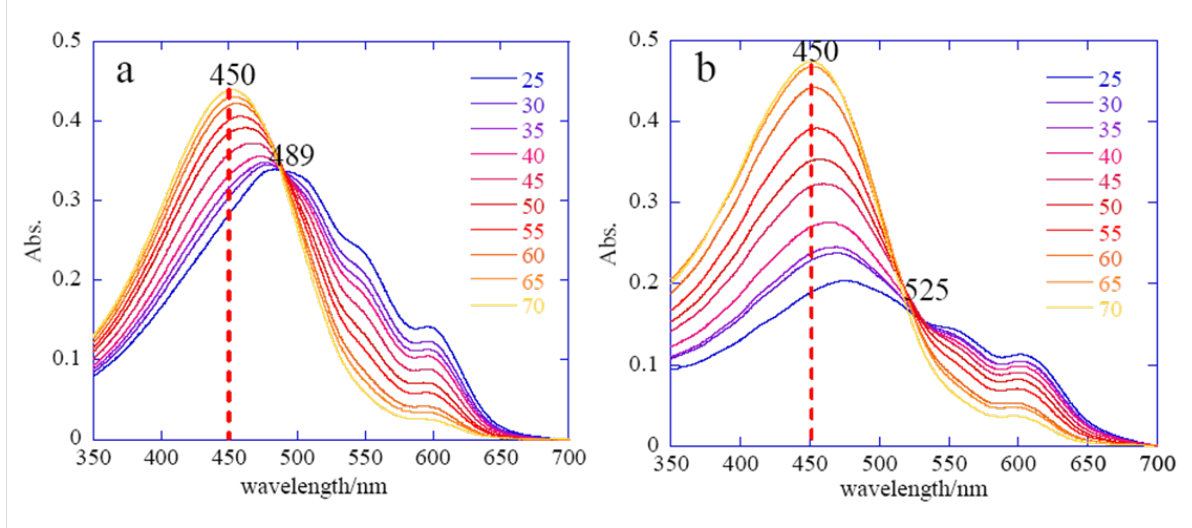
Figure 22: UV–vis absorption spectra of P3HT (a) and P3HT/HT3P-imogolite hybrid (b) in anisole (0.0005%) during cooling. Reprinted with permis- sion from W. O. Yah et al., J. Phys.: Conf. Ser. 2011, 272, 012021 [86]. © IOP Publishing 2011.